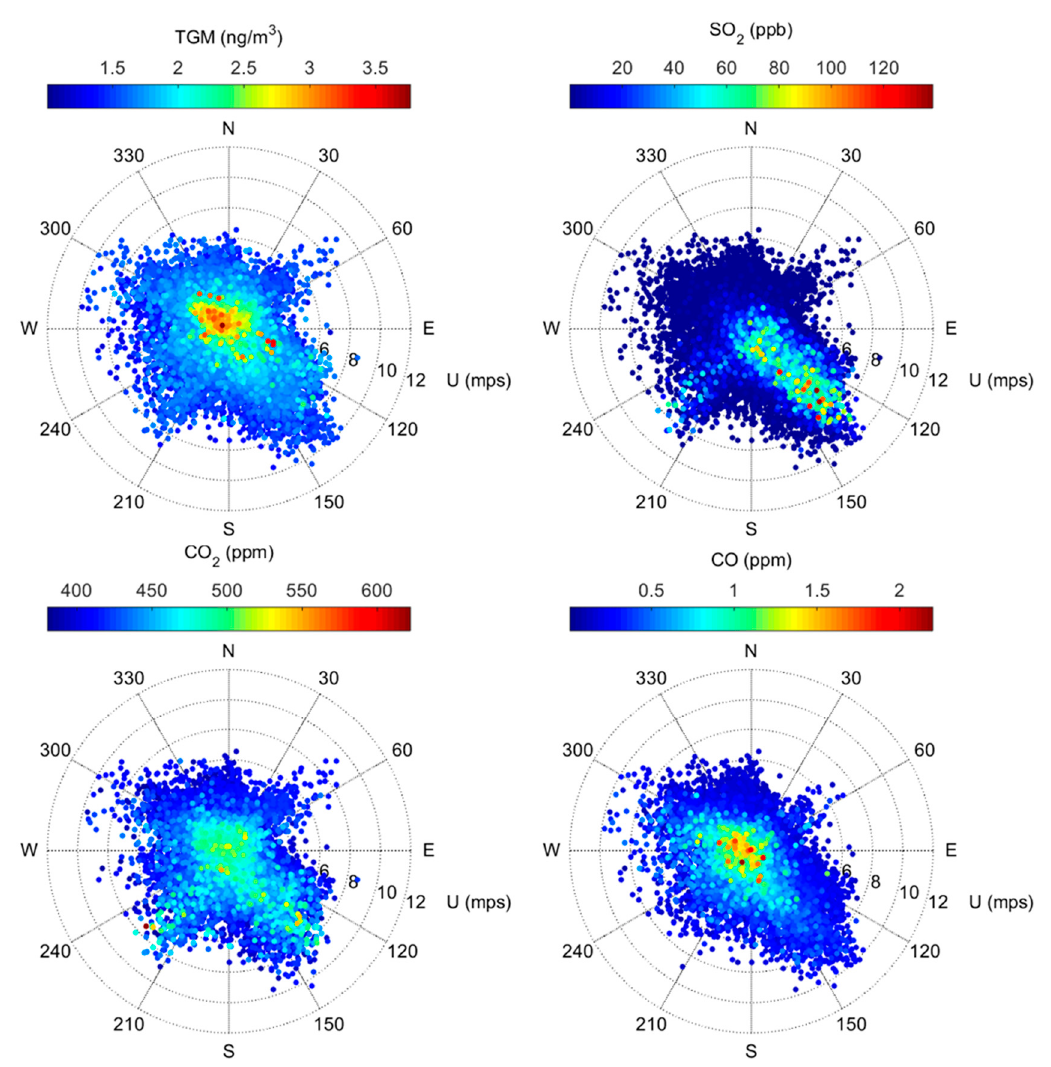
Figure 3. Polar plots of 5-minute TGM, SO 2 , CO 2 , and CO observations at the monitoring site, June